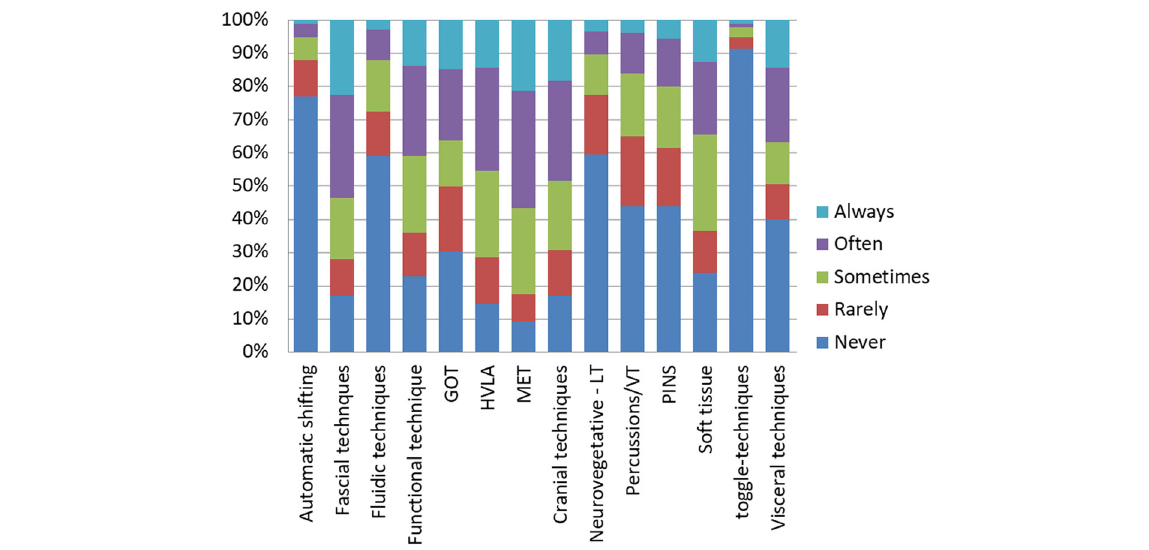
Fig. 5 « How often did you engaged self-directed practice on the following techniques? » . Students had to select one answer (Always, Often, Sometimes, Rarely, Never) for each of the 14 techniques listed. The most used technique was Muscle Energy Technique (MET). The less used technique one was ‘ Toggle-techniques ’ . GOT: General Osteopathic Treatment; HVLA: High Velocity Low Amplitude; LT: lymphatic techniques; VT: vibrational techniques; PINS: progressive inhibition of neuromuscular